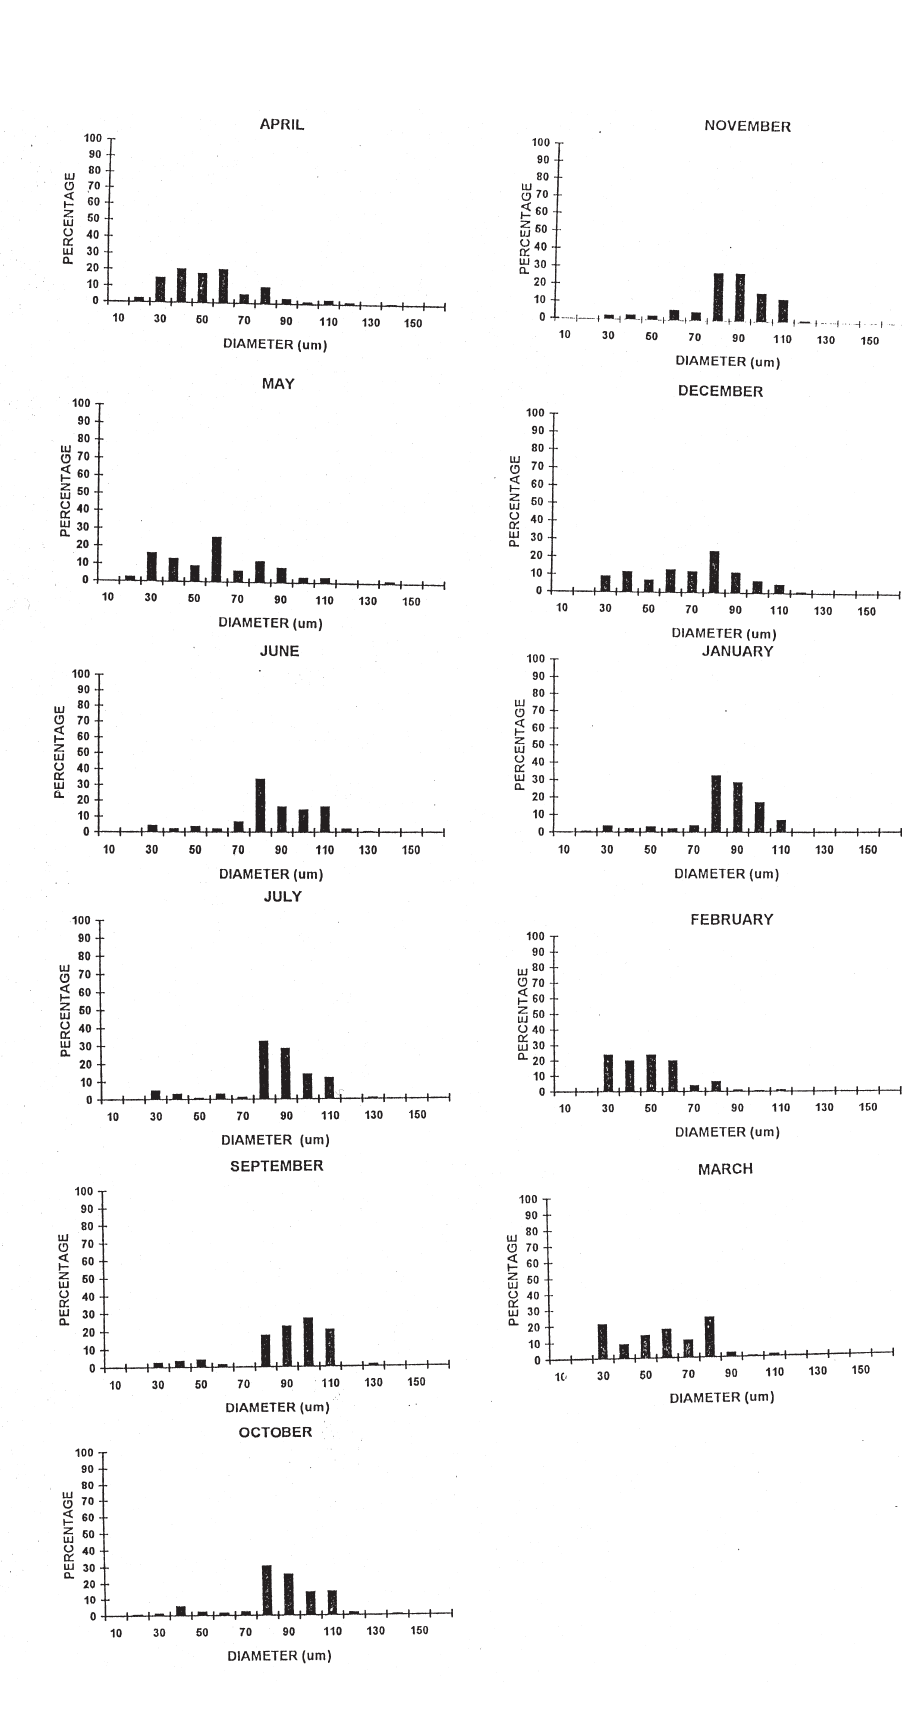
F IG . 7. – Frequency distribution of the diameter of oocytes and/or ova expressed as percentage for organisms collected in Cockburn